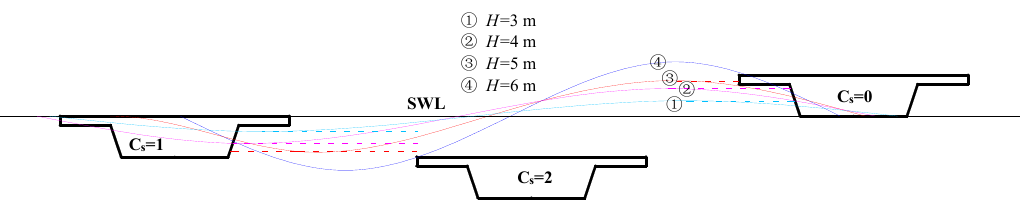
Figure 10. ( a ) Maximum horizontal force ( F H max ) and ( b ) Maximum uplift force ( F v max ) Maximum wave forces versus wave heights ( H ) for the case of box girder under three different submerged coefficients ( C s ).